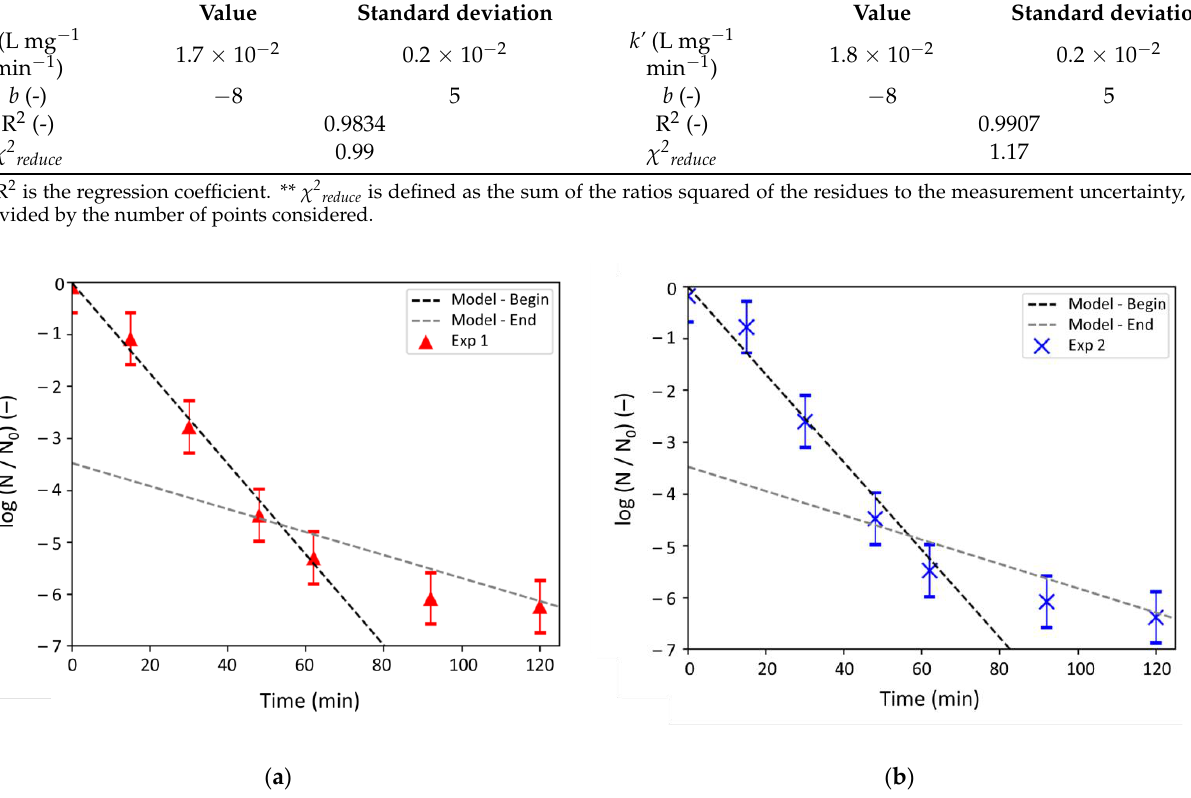
* R 2 is the regression coefficient. ** χ 2reduce is defined as the sum of the ratios squared of the residues to the measurement uncertainty, divided by the number of points considered.